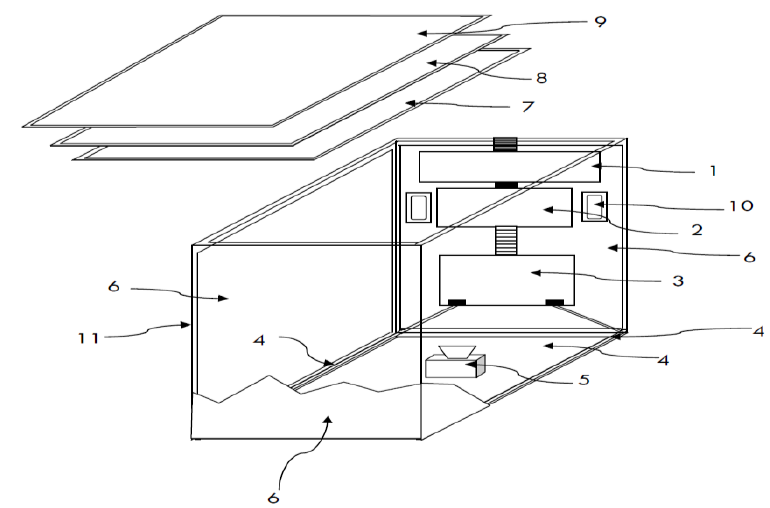
Figure 4. The device design and components of the proposed multi-touch sensing and display system. 1: main circuit board module; 2: AD/DA module; 3: backlight circuit module; 4: backlights; 5: low-cost web-camera; 6: aluminum foil; 7: LCD panel; 8: cellophane paper; 9: acrylic board; 10: speakers; 11: device